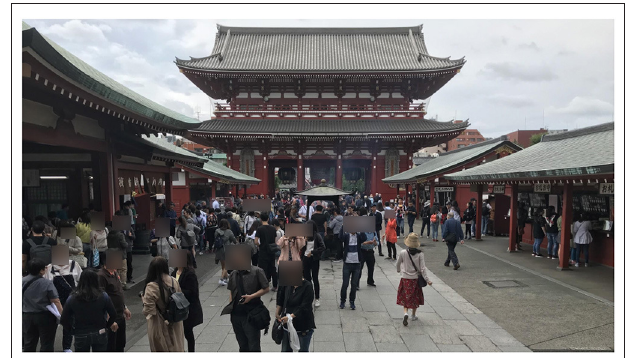
FIGURE 8 | Example of video annotation in Charon. Image reproduced with permission from GNT.